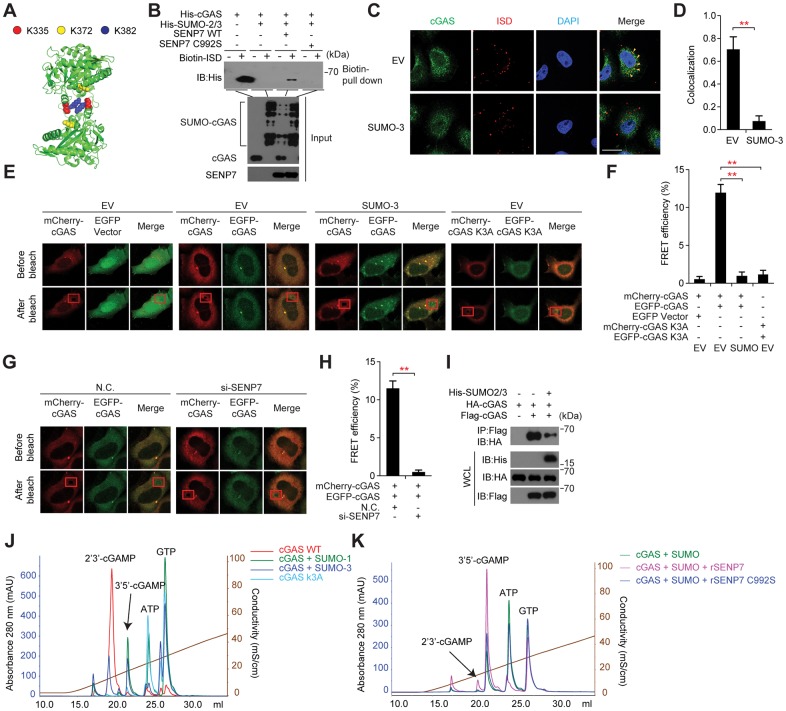
The SUMOylation of cGAS impairs its activation.(A) Modeled structure of the cGAS homo-oligomer; red, yellow and blue spheres indicate SUMOylation sites. (B) DNA-precipitation assay of cGAS alone or cGAS pre-modified with SUMO by incubating with SUMOylation reaction mixture containing E1, E2 and SUMO or de-SUMOylated cGAS by incubating with SENP7 and SENP7 C992S. (C, D) Confocal microscopy of HeLa cells transfected with cyanine dye-3 (Cy3) conjugated ISD (C), and co-localization of cGAS with the labeled ISD (C, D) (Pearson's correlation coefficient; D). Arrows indicate representative co-localization between ISD and cGAS. (E, F) N-terminal EGFP-tagged cGAS and C-terminal mcherry-tagged cGAS or cGAS K3A mutant plasmids were transfected into HeLa cells together with or without His-tagged SUMO. cGAS self-association was examined by FRET assay. Rectangle in red (bottom right image of each group) indicates photobleached area (E). (F), summary of results, presented relative to initial FRET. (G, H) The indicated siRNAs were transfected into HeLa cells. 48 hr later, cells were transfected again with N-terminal GFP-tagged cGAS and C-terminal mcherry-tagged cGAS plasmids together with or without His-tagged SUMO. cGAS self-association was examined by FRET assay. Rectangle in red (bottom right image of each group) indicates photobleached area (G). (H), summary of results, presented relative to initial FRET. (I) Cell lysates from HEK293T cells transfected with the indicated plasmids were immunoprecipitated with an anti-Flag antibody, and then immunoblotted with the indicated antibodies. (J, K) Reaction products from cGAS, SUMOylated cGAS and cGAS K3A (J) as well as WT or catalytically-dead SENP7-treated SUMOylated cGAS (K) were analyzed by ion exchange chromatography. 0.2 mg/mL Salmon sperm DNA was added to stimulate cGAS catalytic activity. Graphs show the mean ± s. d. and data shown are representative of three independent experiments. **P < 0.01 (two-tailed t-test). Scale bars, 25 μm.